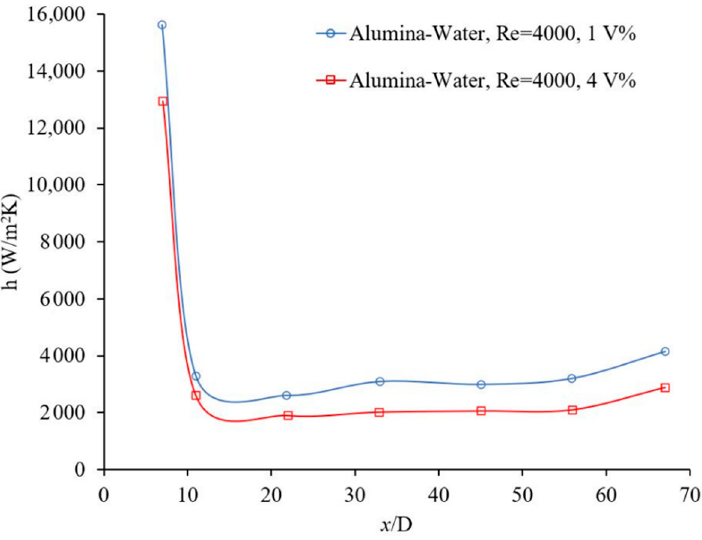
Figure 2. Effect of volume concentration on heat transfer coefficient, Sahin et al. [21].